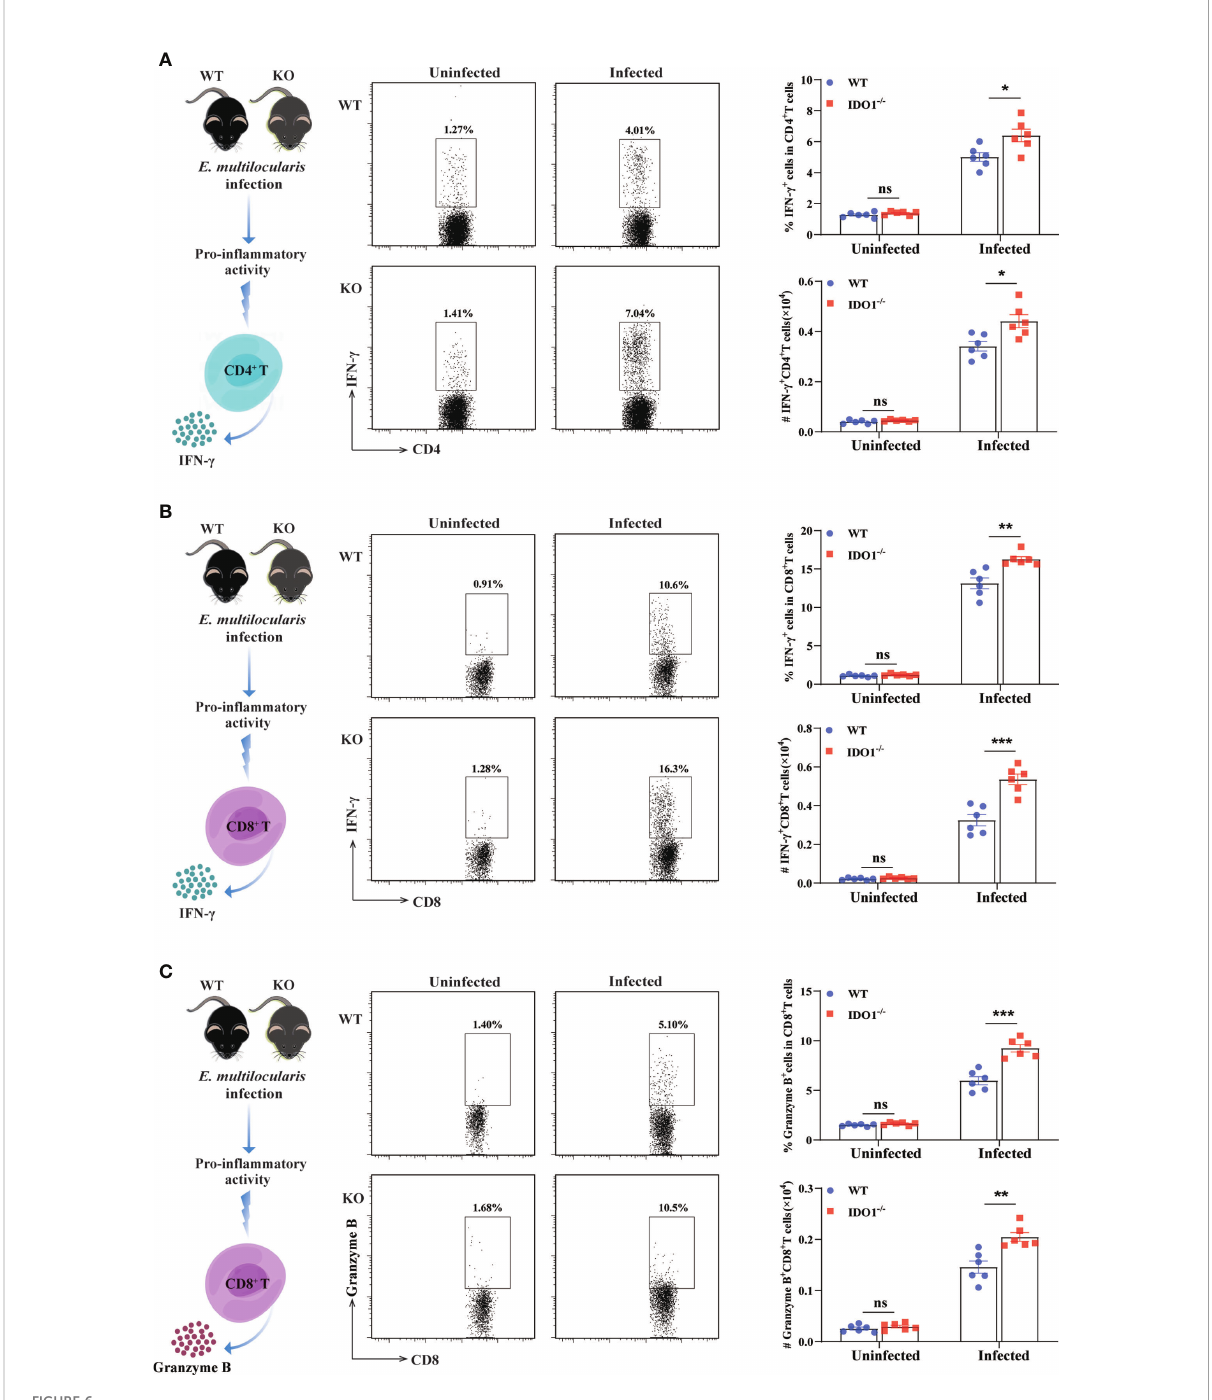
FIGURE 6 Enhanced Th1 and CTL development in IDO1 -/- mice infected with E multilocularis. (A, B) Conceptual schematic diagram (left), representative fl ow cytometry plots (middle), and the frequency (upper right) and the absolute number (lower right) of IFN- g secreting CD4 + T cells (A) , IFN- g secreting CD8 + T cells (B) , and granzyme B secreting CD8 + T cells (C) of the IDO1 -/- and wild-type mice at 3 months post-infection with E multilocularis (n = 6/group). CD45 + CD3 + CD4 + and CD45 + CD3 + CD8 + cells were gated respectively for panel (A) and (B, C) . Data are pooled from 2 independent experiments, and presented as the mean ± SEM. ns, not signi fi cant; *, p < 0.05; **, p < 0.01; *** p <